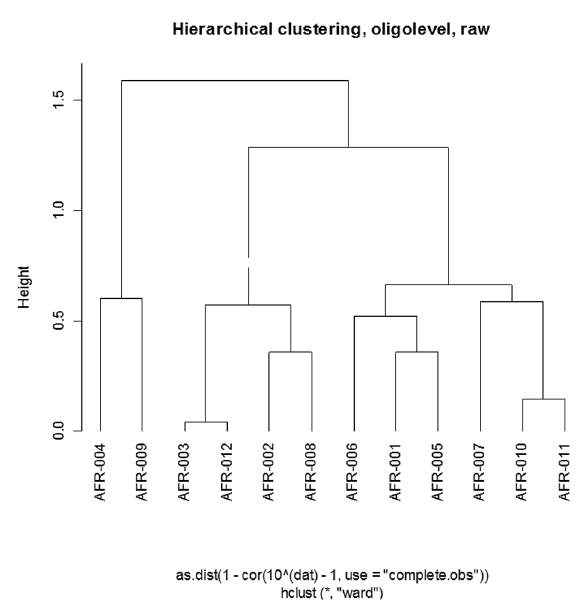
Figure 1. Dendrogram of the samples’ clustering based on the global HITChip oligonucleotide probe signal intensities (AFR001-006; Healthy patients’ samples, AFR007-012: Polyp patients’ samples).